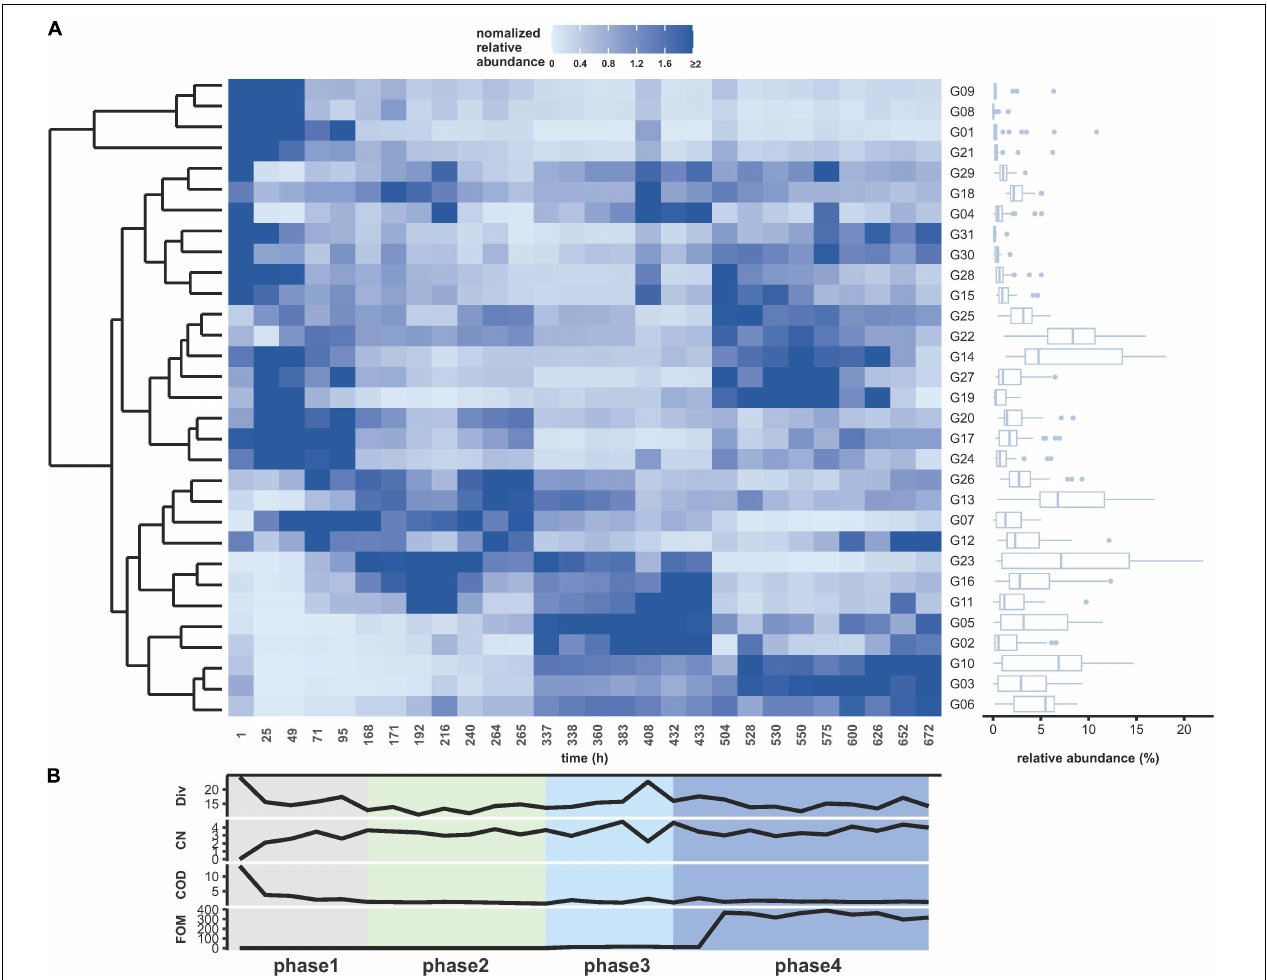
FIGURE 2 | Community dynamics during continuous cultivation for 672 h. (A) Cytometrically analyzed relative cell abundances (%) per subcommunity relative to the number of cells for each measurement (G01–G31). The relative cell abundance values were normalized by the average relative cell abundance per subcommunity over time (blue: higher than average, light blue: lower than average). The relative cell abundance per subcommunity was summarized as box plot (right side). The upper and lower edges of the boxes indicate 75th and 25th percentile; the middle line indicates the median. Points indicate the outliers. Clustering of subcommunities was arranged according to the similarity of their abundance changes over time (left side). (B) Variation in the concentrations of abiotic parameters from bottom to top: FOM (fosfomycin, mg L − 1 ), COD (O 2 , mg ml − 1 ), and CN ( × 10 10 counts ml − 1 ). In addition, the variation in α -diversity (Div, order-based Hill number q = 2) was given. The experiment was subgrouped in four phases—gray, adaptation; green, gfp-labeled P. putida KT2440 augmentation; light blue, fosfomycin 10 mg L − 1 ; blue, fosfomycin 268 mg L − 1 (details in Table 1 ).